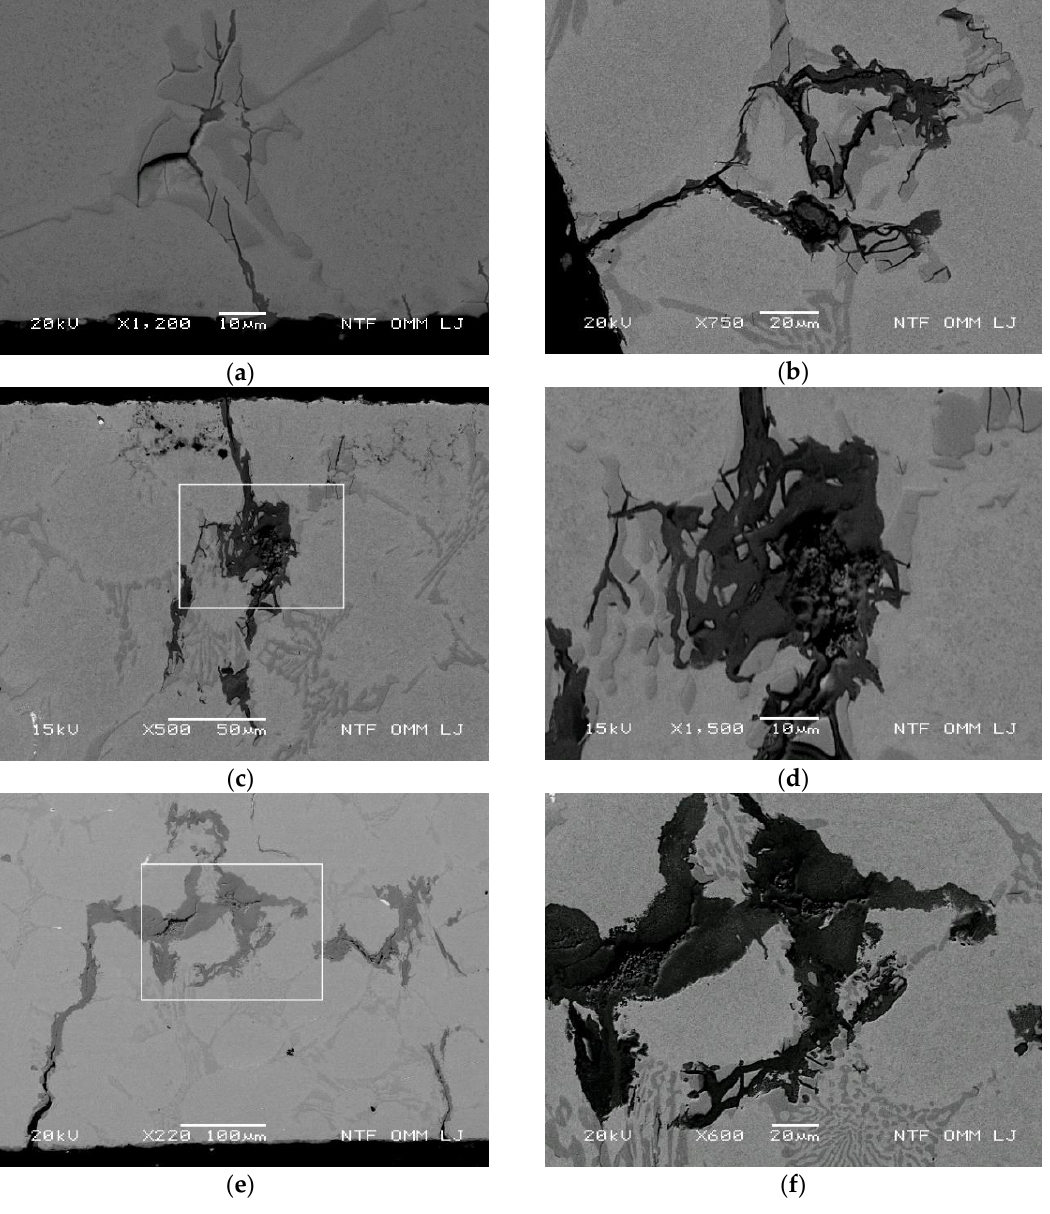
Figure 6. Oxidation of the cracked eutectic carbides below the cooled surface with the crack canal to the cooled surface: ( a ) cracking and initial oxidation of the subsurface eutectic after 500 cycles at 600 °C, ( b ) after 1000 cycles at 600 °C, ( c ) after 2500 cycles at 600 °C with marked area for the detail, ( d ) micrograph of the detail of oxidized eutectic cluster, ( e ) oxidation area expansion in the axial direction after 2500 cycles at 700 °C and, ( f ) detailed view of the area marked in the subfigure e.